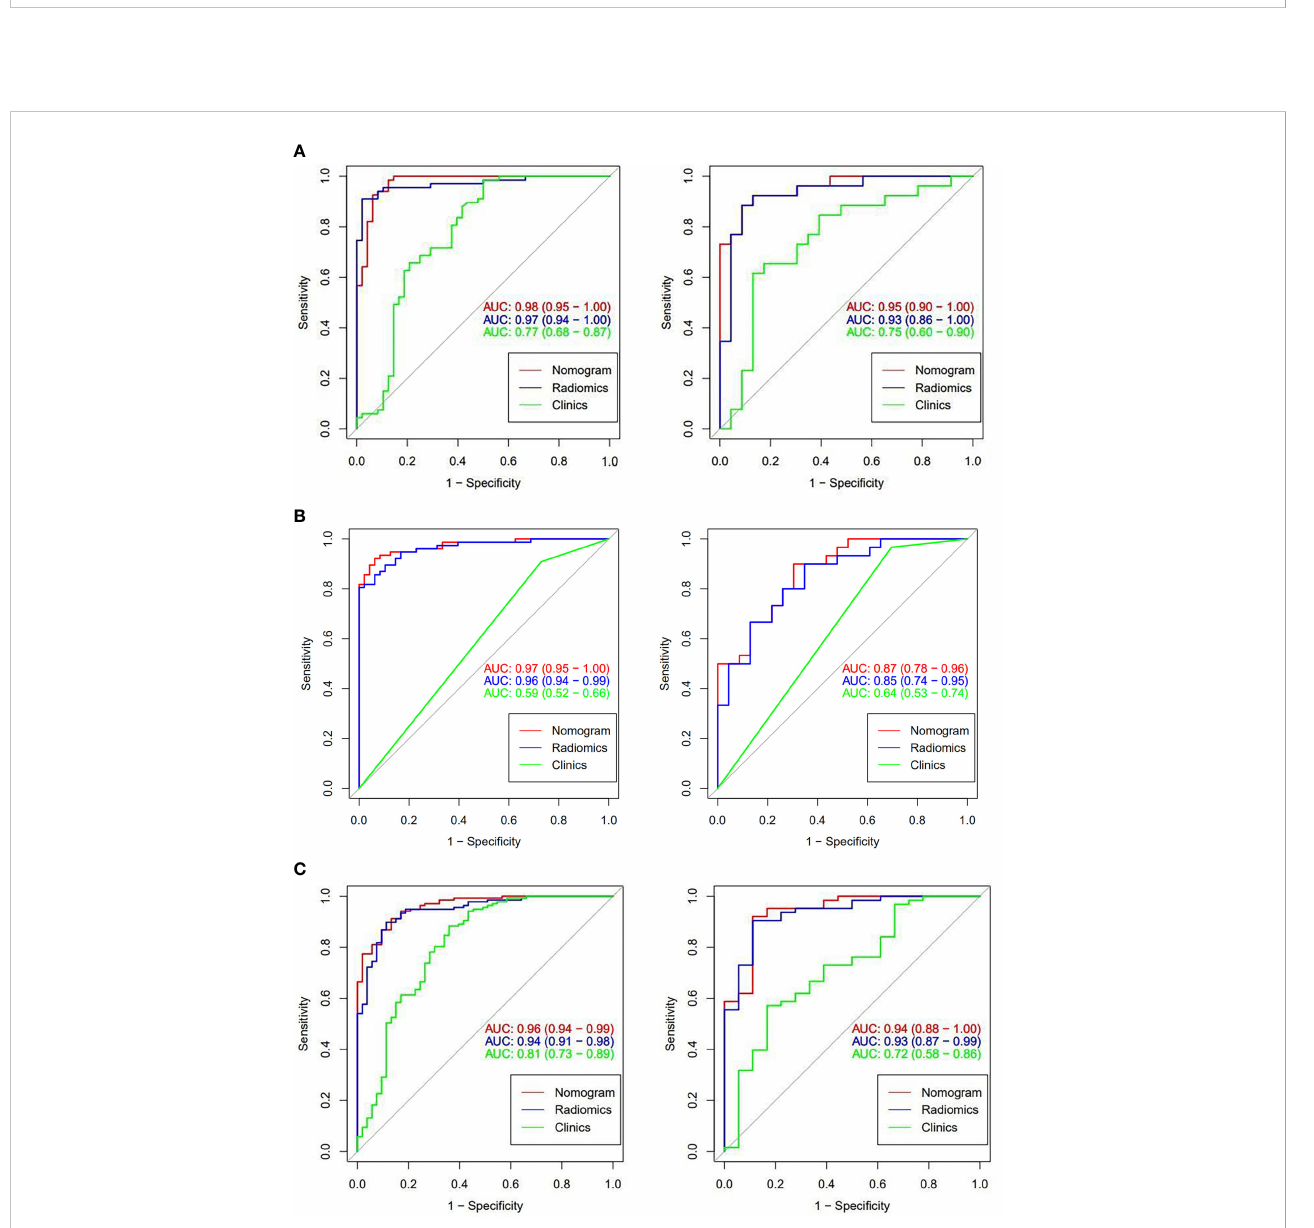
FIGURE 10 ROC curves of models 1, 2, and 4 for the corresponding classi fi cation ef fi cacy of the radiomics models, clinical features, and nomogram models in the training group and test group. ( A are the training group and test group of model 1, respectively; B are the training group and test group of model 2; and C are the training group and test group of model 4).